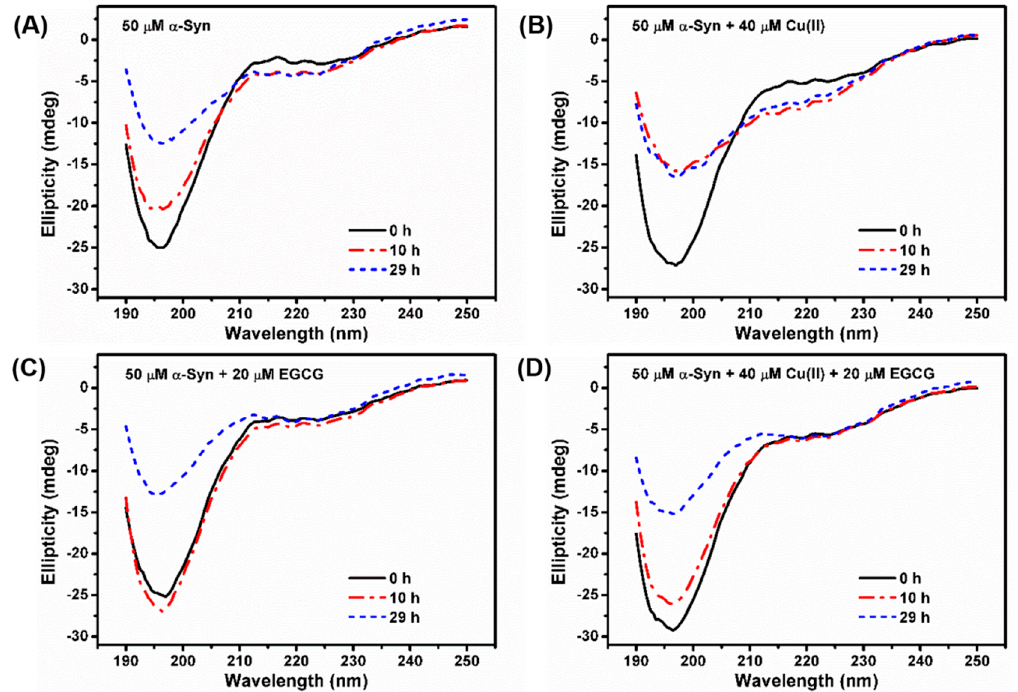
Figure 3. CD spectra of 50 μ M α -Syn incubated in the absence ( A ) or presence of ( B ) 40 μ M Cu(II), ( C ) 20 μ M EGCG, ( D ) the mixture of 20 μ M EGCG and 40 μ M Cu(II) after incubation for 0 h (line in black), 10 h (dash in red), and 29 h (dot in blue).